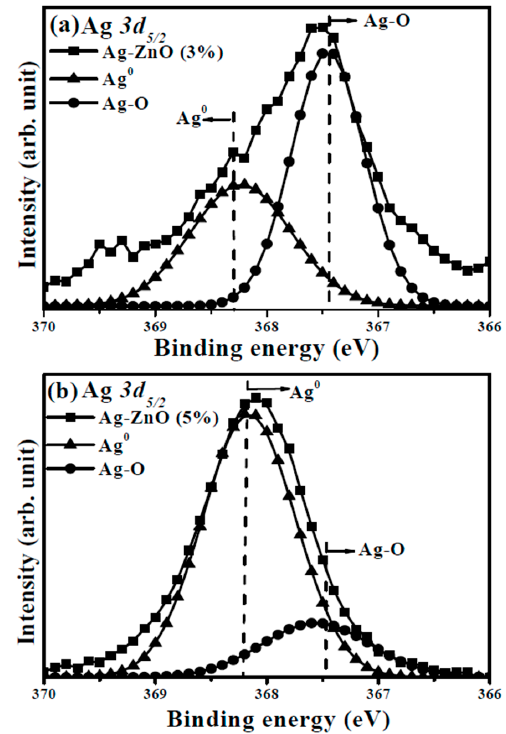
Figure 8. Core level of the Ag 3d 5/2 spectra for the Ag-ZnO co-sputtered films at the theoretical atomic ratios of ( a ) 3% and ( b ) 5%, respectively, after annealing at 350 °C for 1 h under ambient air.